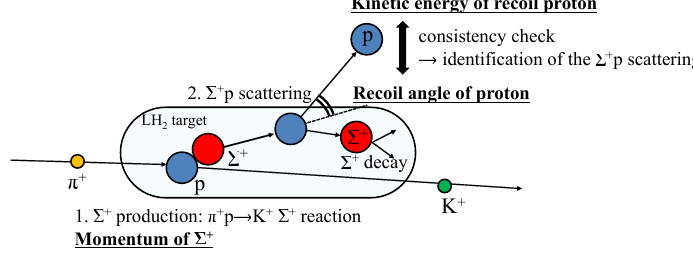
Figure 1. Experimental concept of the Σ + p scattering experiment. The LH 2 target was used as the target for both Σ + production and Σ + p scattering. Σ + p scattering events can be kinematically identi fi ed by measuring the incident Σ + ’s momentum, the recoil proton’s kinetic energy, and recoil